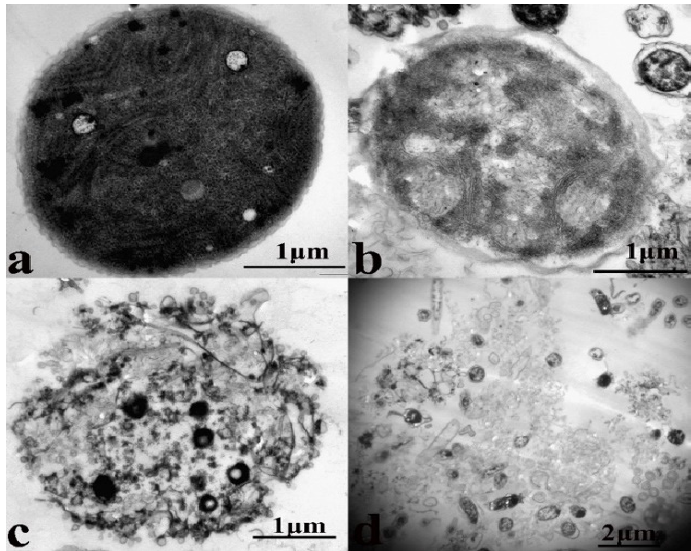
Figure 12. The structural changes of 91 # bacteria to Microcystis aeruginosa under scanning electron microscope. ( a ): Normal algae. ( b – d ): Changes after 1, 2, 3 days of inoculation of 91 # bacterial solution, respectively.